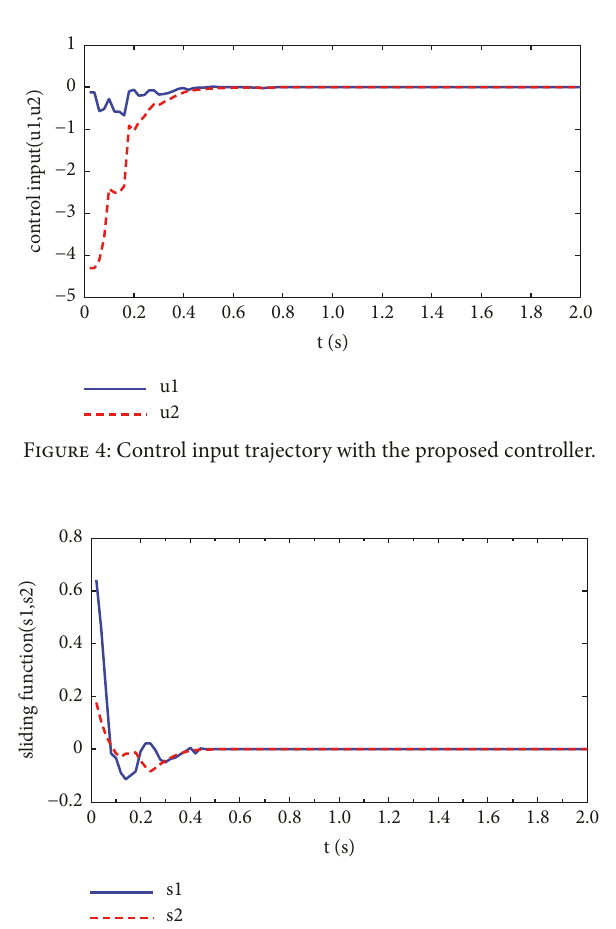
Figure 5: Sliding function trajectory with the proposed controller.